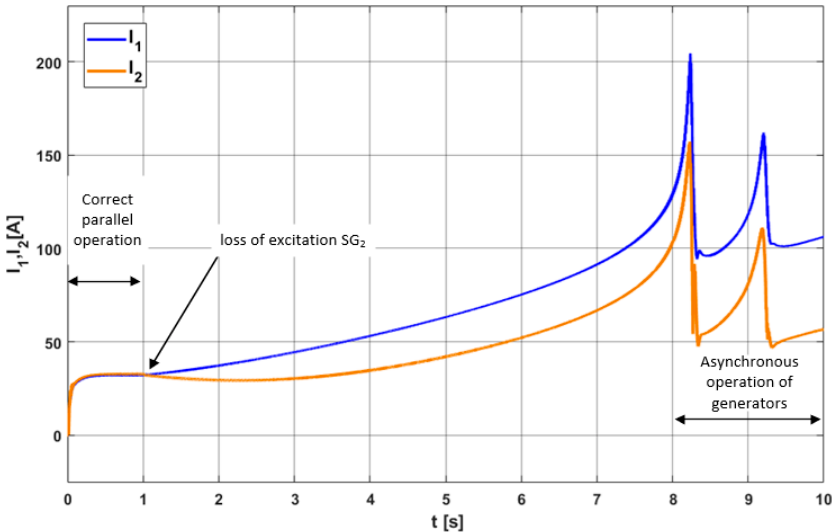
Figure 10. Values of the apparent currents I 1 and I 2 operating in parallel (SG 1 and SG 2 ). The current I 1 of SG 1 (of the undamaged generator) increases faster than the current I 2 of SG 2 . This is caused by the fact that the reactive current of SG 1 is the sum of the reactive current of SG 2 and the reactive current of the load (Figure 4). The results of the simulation tests confirm the previously conducted analysis (Figure 5).